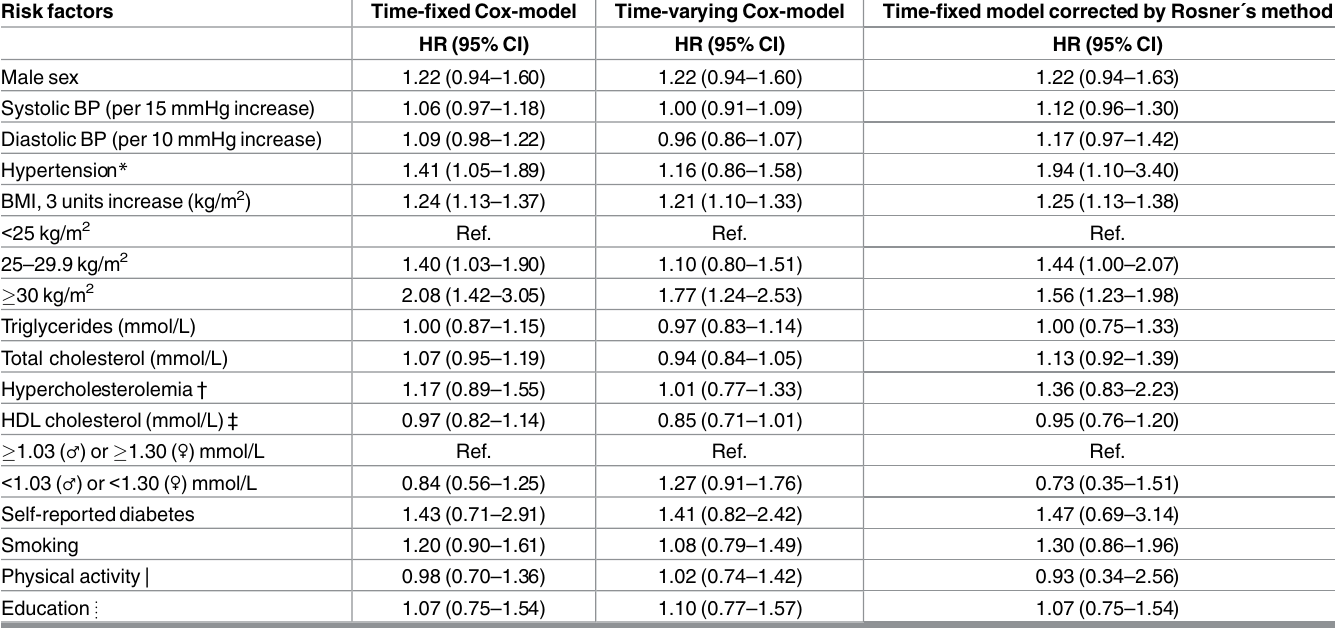
Table 3. Age (as time scale)-and sex-adjusted hazard ratios(HR)with95% confidence intervals(CI)for the risk of venousthromboembolism (VTE)by traditionalatherosclerotic risk factorsusingthreedifferent approaches; time-fixedmodel,time-varyingmodeland correctionfor regres- sion dilutionthroughRosners´s method. The Troms ø Study